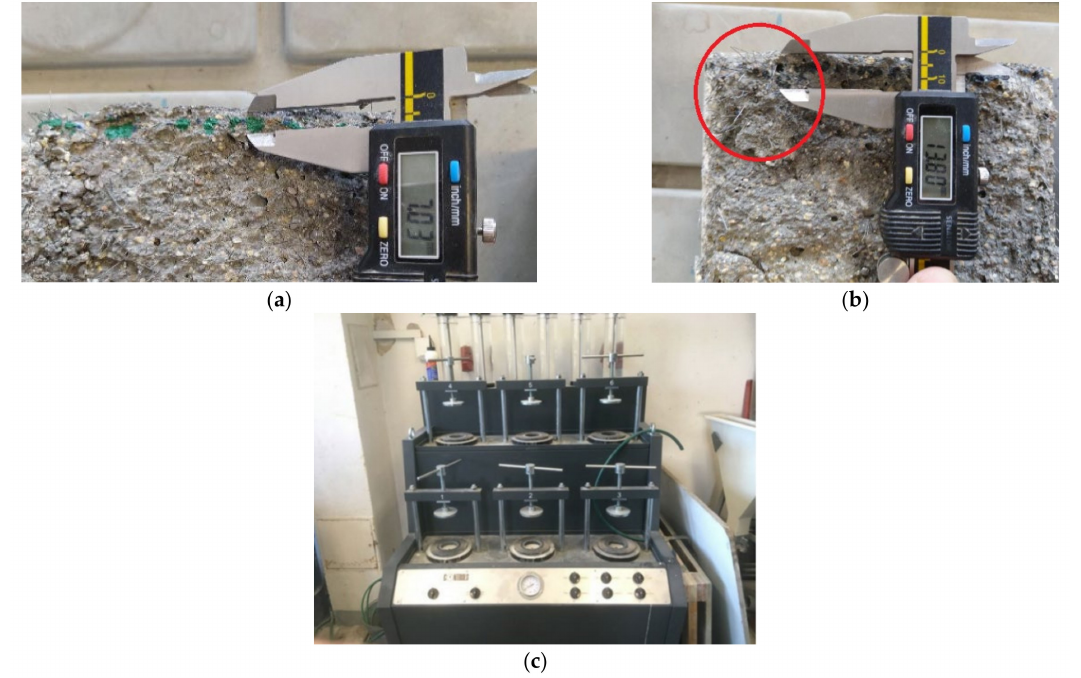
Figure 14. Seep depth experimental samples. ( a ) Fiber-reinforced concrete—sample 1; ( b ) fiber- reinforced concrete—sample 2; ( c ) machine for testing the depth of penetration with pressurized water in